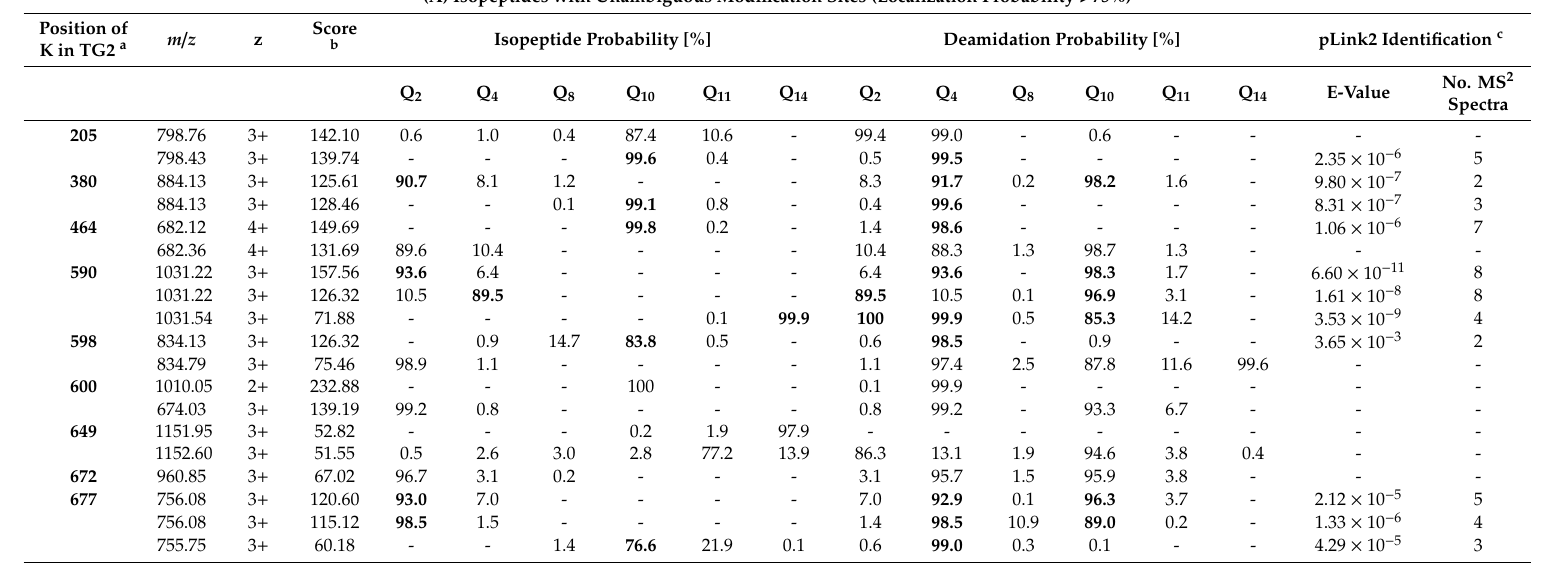
Table 4. Glutamine binding and deamidation sites in P2 (VQ 2 GQ 4 GIIQ 8 PQ 10 Q 11 PAQ 14 L) involved in the formation of 33 isopeptides with di ff erent lysine residues of TG2. Modified sites identified with pLink2 are given in